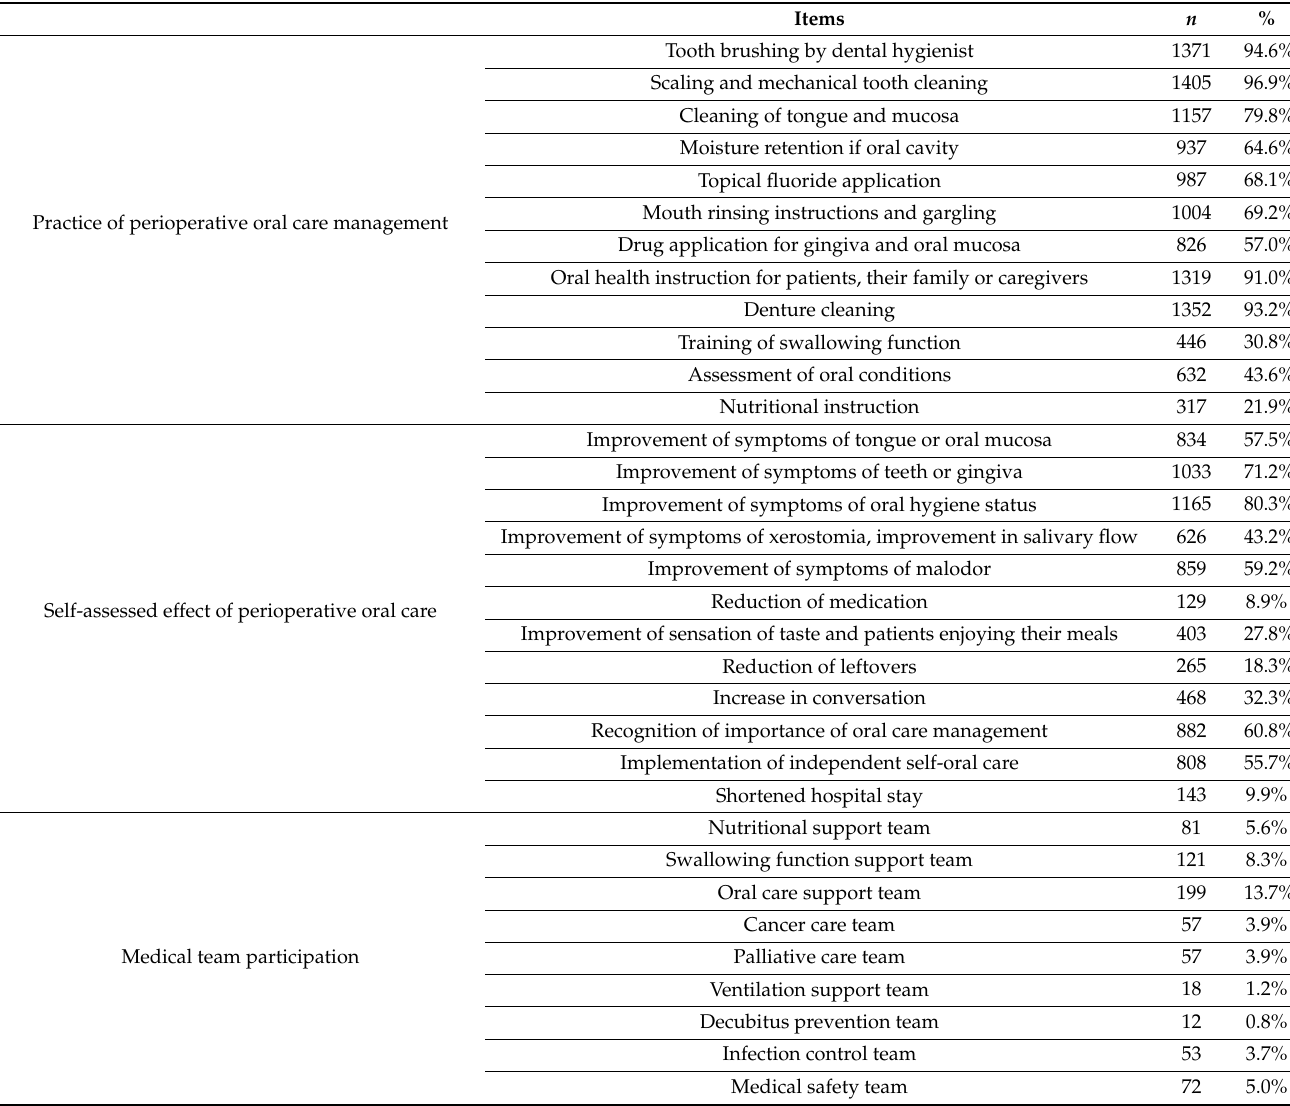
Table 1. Descriptive statistics of the items investigated in this